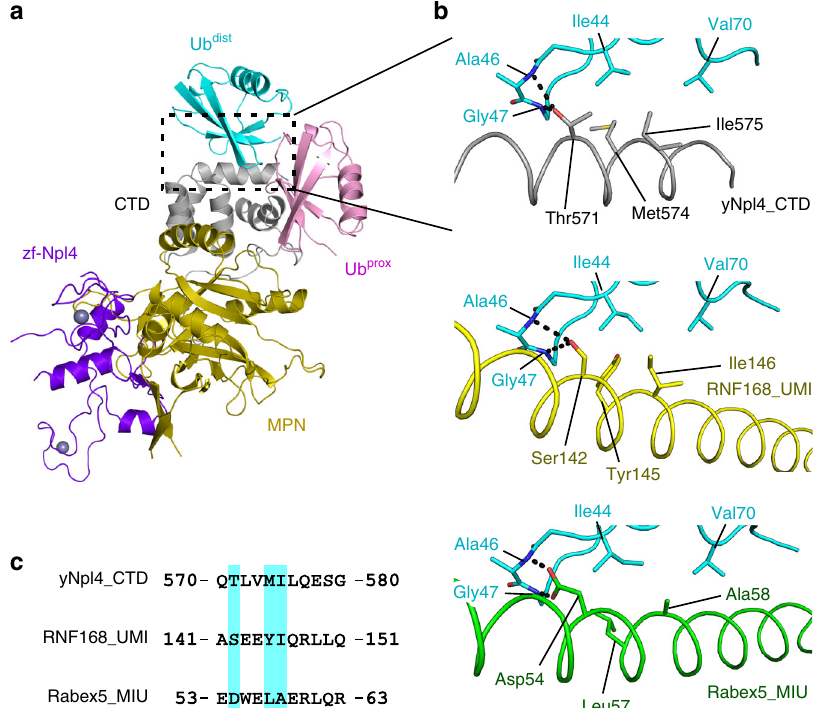
Fig. 5 Comparison of the C-terminal helix of yNpl4, RNF168 UMI, and Rabex-5 MIU. a Overall structure of the yNpl4 – K48-Ub 2 complex. The coloring scheme is the same as that in Fig. 2a. b Structural comparison of the Ub-binding interfaces of the C-terminal helix of yNpl4 (this study), RNF168 UMI (PDB 5XIS [https://doi.org/10.2210/pdb5xis/pdb]) 38 , and Rabex-5 MIU (PDB 2C7M [https://doi.org/10.2210/pdb2c7m/pdb]) 39 . The coloring scheme of the yNpl4 – Ub dist complex is the same as that in Fig. 2a. RNF168 UMI and Rabex-5 MIU are colored yellow and green, respectively. Hydrogen bonds are shown as black dotted lines. The residues involved in the binding between yNpl4 and Ub dist and the corresponding residues of RNF168 UMI and Rabex-5 MIU are shown as sticks. c Sequence alignment of the C-terminal helix of yNpl4, RNF168 UMI, and Rabex-5 MIU. The residues involved in the binding between yNpl4 and Ub dist and the corresponding residues of RNF168 UMI and Rabex-5 MIU are highlighted in cyan.